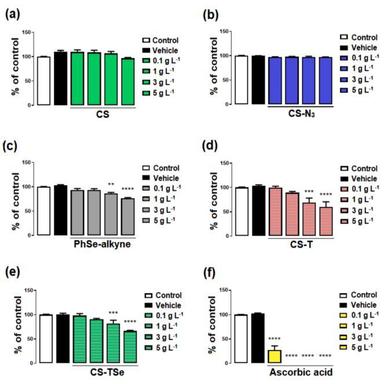
Effect of (a) CS, (b) CS-N3, (c) PhSe-alkyne, (d) CS-TSe, and (e) ascorbic acid at different concentrations (0.1–5 g L− 1 ) on ABTS+ radical-scavenging activity. Data are expressed as the mean ± SEM for three independent experiments, carried out on different days. The results are calculated as % of control of the absorbance at λ = 734 nm. Asterisk denotes significance levels when compared with the control group: (\\\) P < 0.001 and (\\\\) P < 0.0001 (Oneway ANOVA followed by the Tukey's test).